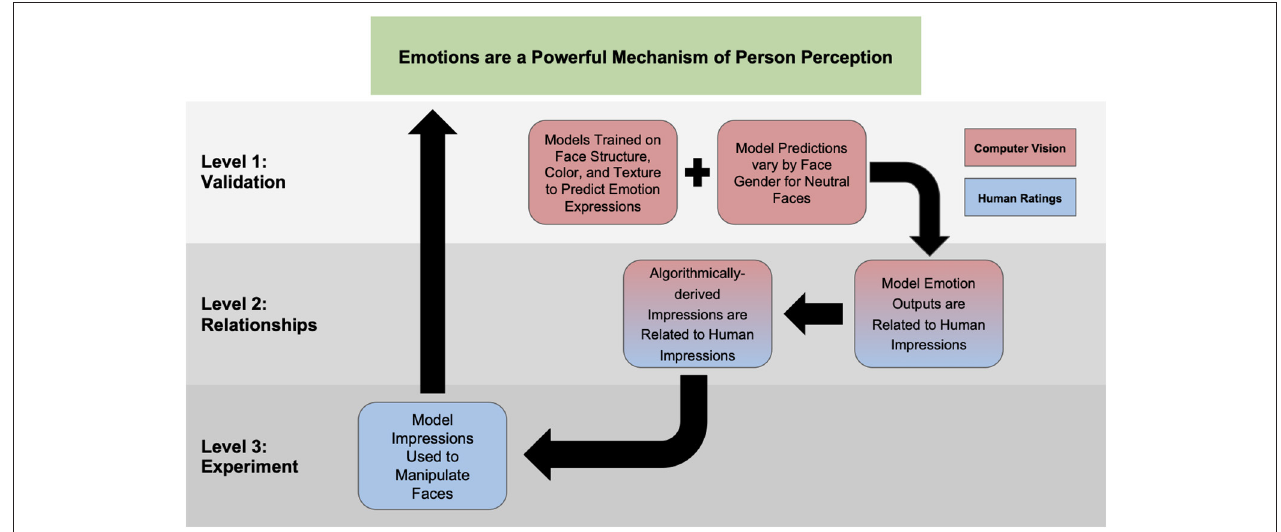
FIGURE 1 | Theoretical roadmap for the current set of studies. Our overall central thesis is presented at the top of the figure. Study 1 corresponds to Level 1; Studies 2 & 3 correspond to Level 2; Study 4 corresponds to Level